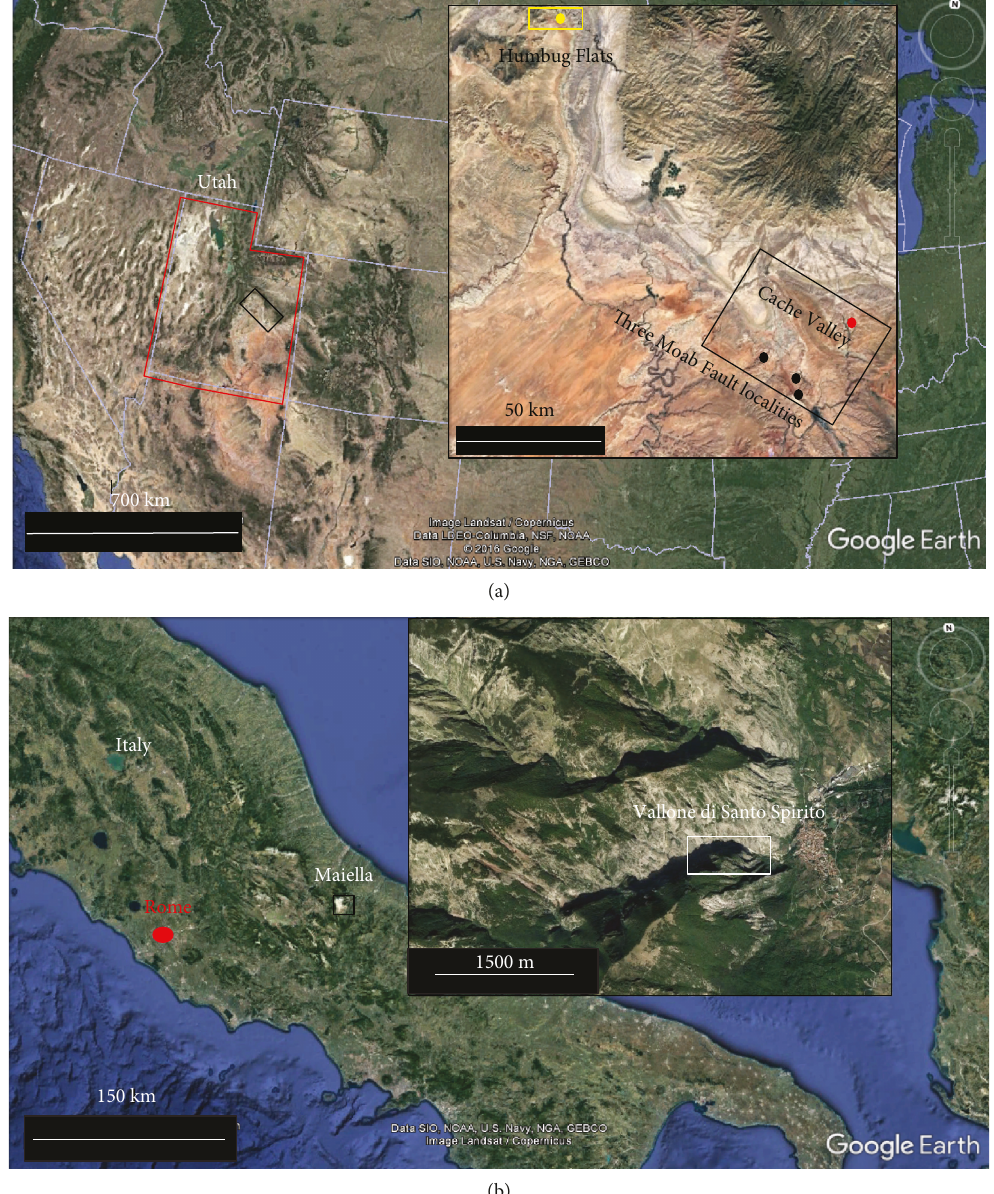
Figure 3: Google maps of the studied areas in Utah (USA) and Maiella (Italy). (a) Three localities studied around the Moab Fault and one in the Cache Valley are all in the Paradox Basin. The Humbug Flats outcrop is located in the San Rafael Swell. (b) The outcrops in Vallone di Santo Spirito were studied in the Maiella study